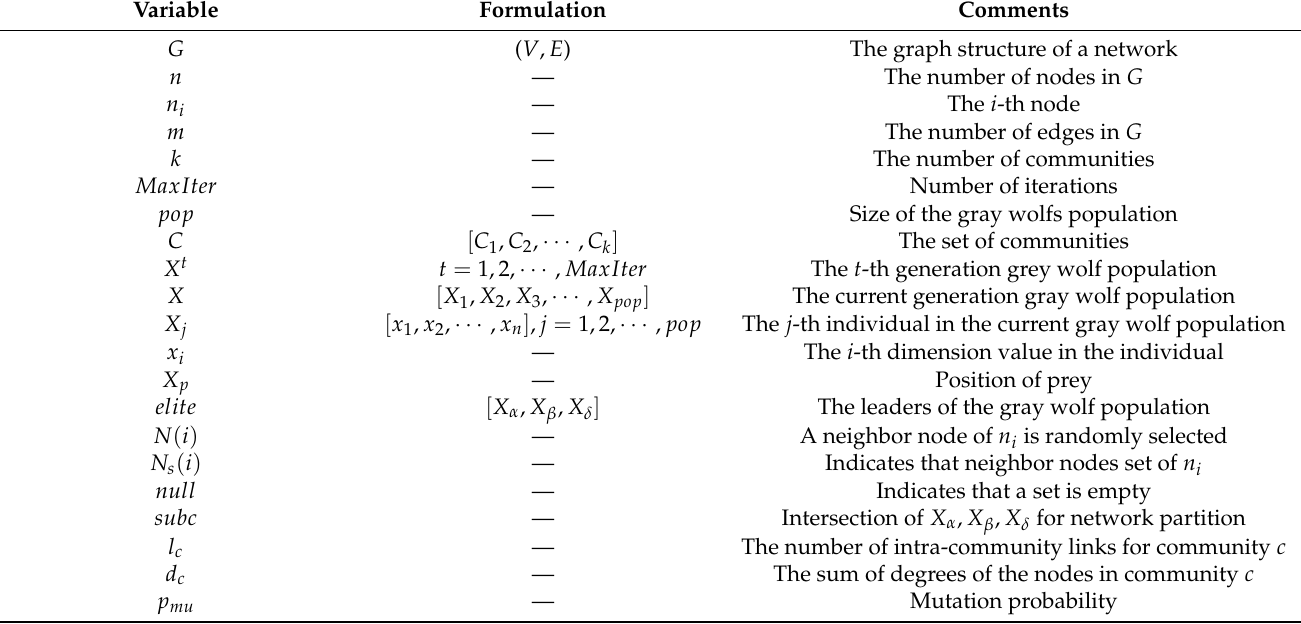
Table 1. Symbolic representation of the